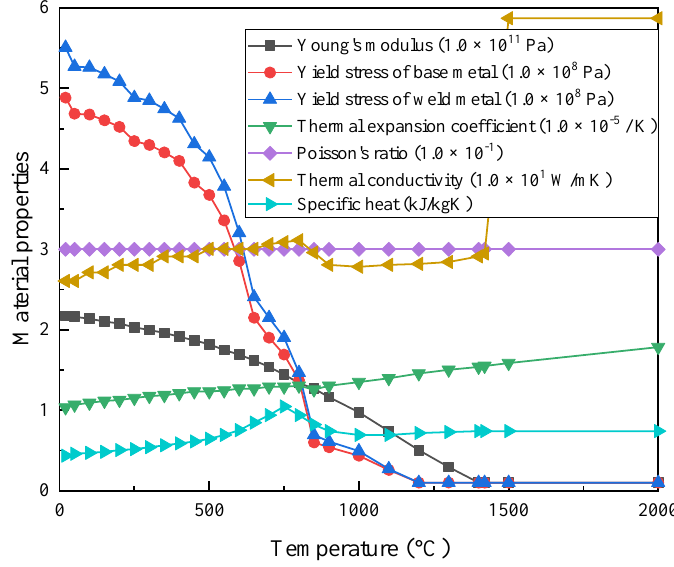
Figure 6. Temperature-dependent thermal physical properties and mechanical properties, for base metal and weld metal, used in the FE simulation, data from